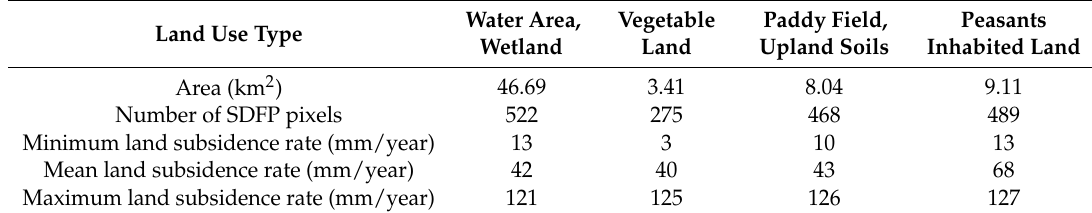
Table 6. Characteristics of land subsidence in different land use types.